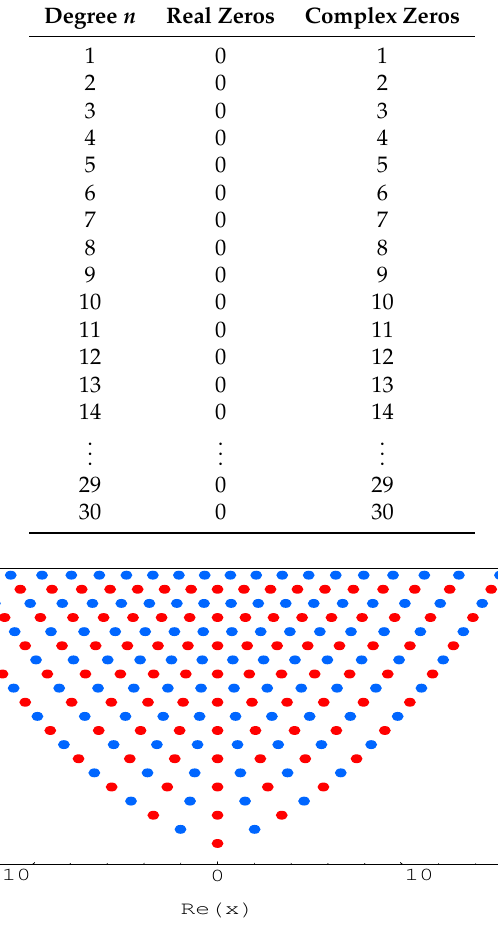
Figure 4. Real zeros of H n ( x , − 2 ) for 1 ≤ n ≤